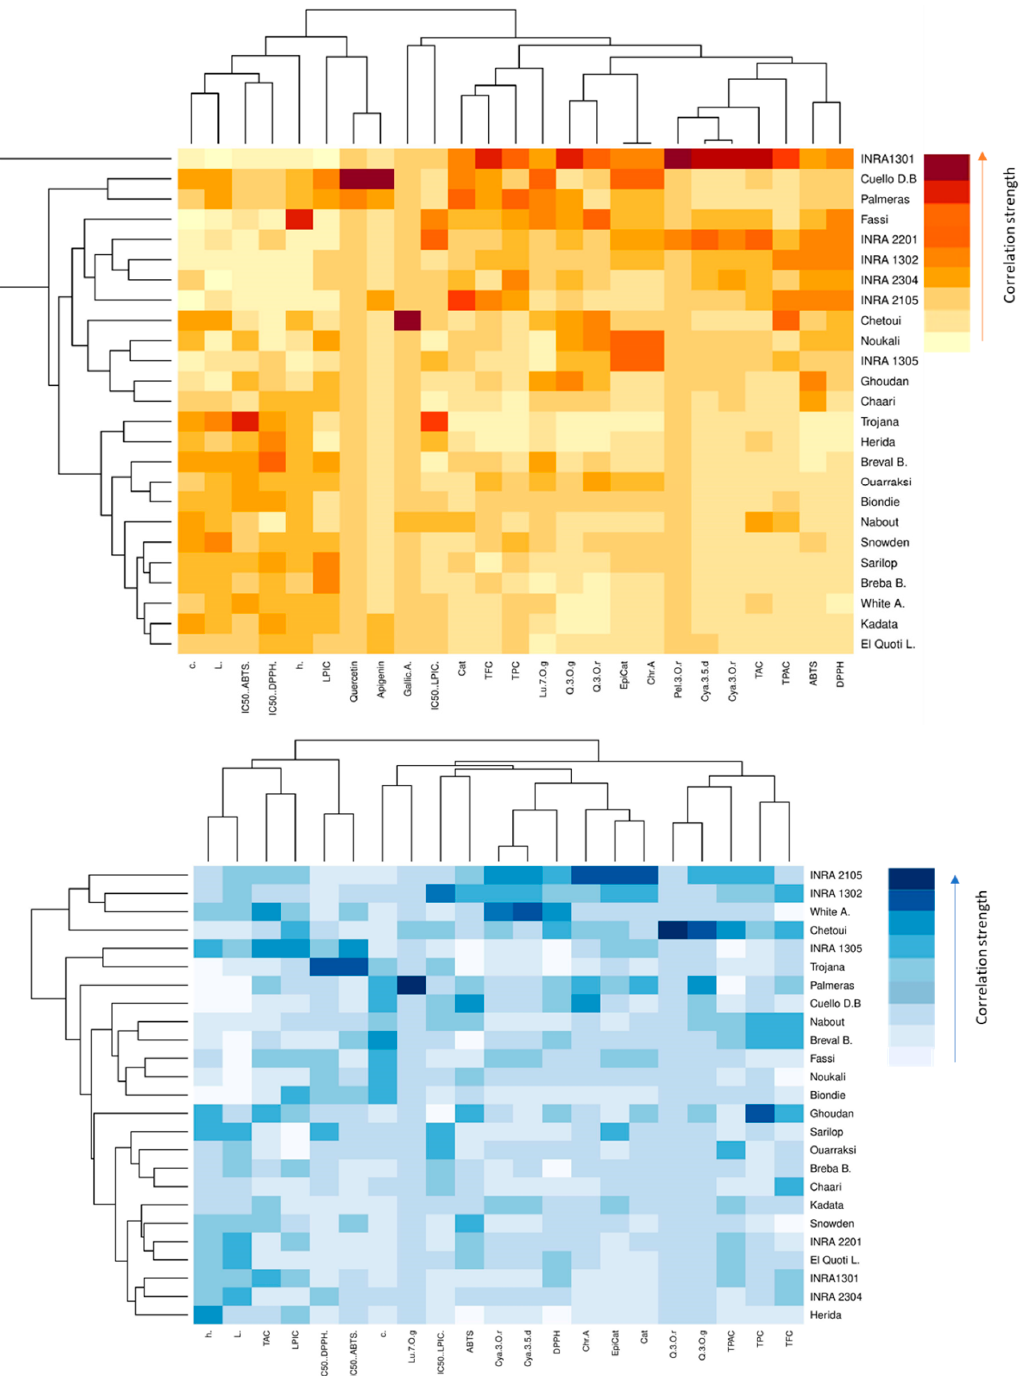
Figure 4. Hierarchically clustered heatmap based on the correlation matrix of studied variables in both peel ( red map ) and pulp ( blue map ). The low color intensity means the lower value and vice versa. Chr.A: chlorogenic acid; Q.3.O.r: quercetin-3- O -rutinoside; Q.3.O.g: quercetin-3- O -glucoside; Lu.7.O.g: luteolin-7- O -glucoside; Quercetin: quercetin; Apigenin: apigenin; Cya.3,5.d: cyanidin-3,5-diglucoside; Cya.3.O.r: cyanidin-3- O -rutinoside; Pel.3.O.r: pelargonidin-3-O-rutinoside. White A.: “White Adriatic”; Cuello B.D: “Cuello Dama Blanca”; Breval B.: “Breval Blanca”; Breba B.: “Breba Blanca”; El Quoti L.: “El Quoti